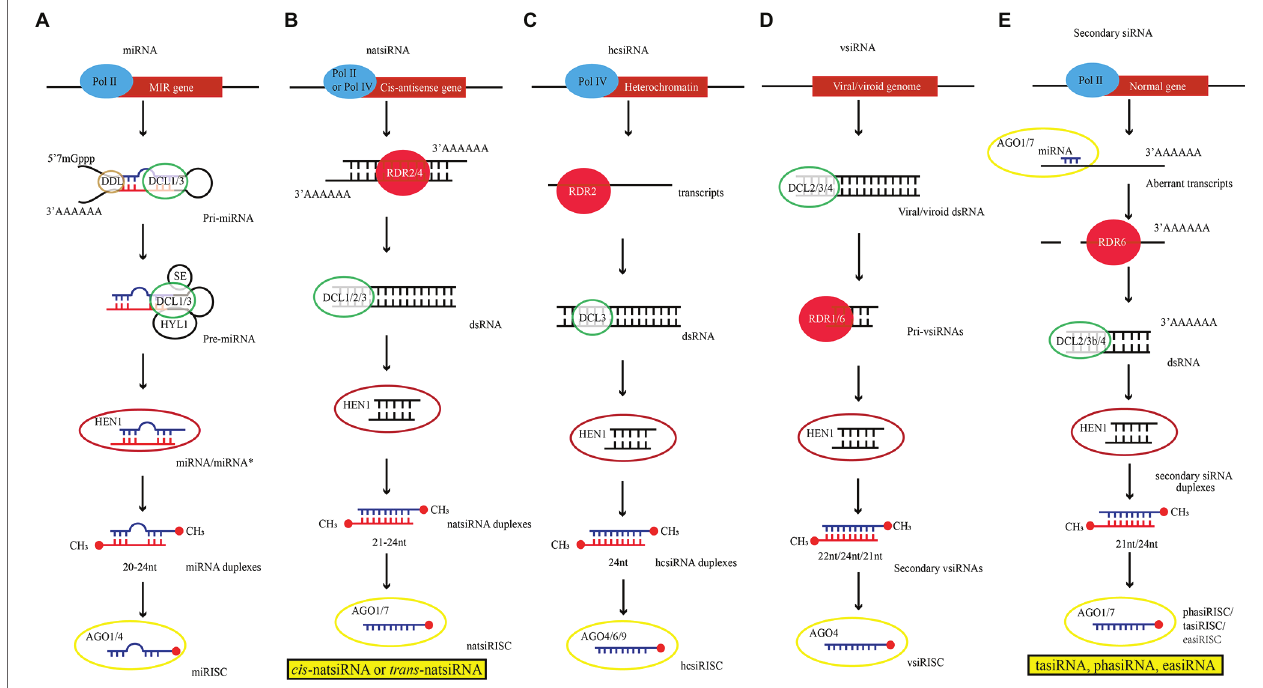
FIGURE 1 | Illustrations of siRNA biogenesis in plants (Ref Borges et al., 2018; Singh et al., 2021). (A) miRNA biogenesis model derived from MIR gene. (B) natsiRNA biogenesis model derived from Cis-antisense gene. (C) hcsiRNA biogenesis model derived from Heterochromatin. (D) vsiRNA biogenesis model derived from Viral/viroid genome. (E) Secondary siRNA biogenesis model derived from Normal gene. Pol: RNA Polymerase; DDL: Dawdle; DCL: RNase III enzyme DICER-LIKE; SE: SERRATE; HYL1: HYPONASTIC LEAVES1; HEN1: HUA ENHANCER 1; RDR: RNA-DEPENDENT RNA